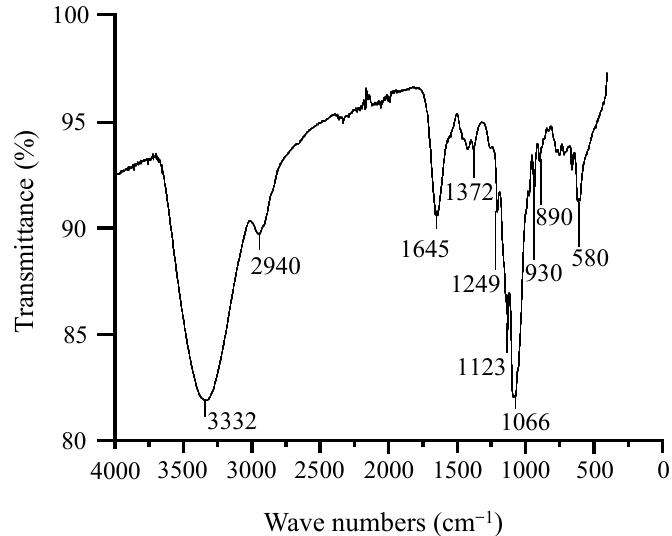
Figure 3. Atomic force micrograph of G. blodgettii polysaccharide: ( A ) 2D; ( B ) 3D; ( C ) height distribution graph.